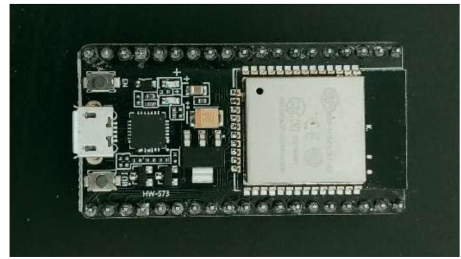
Figure 5. The ESP32S development board